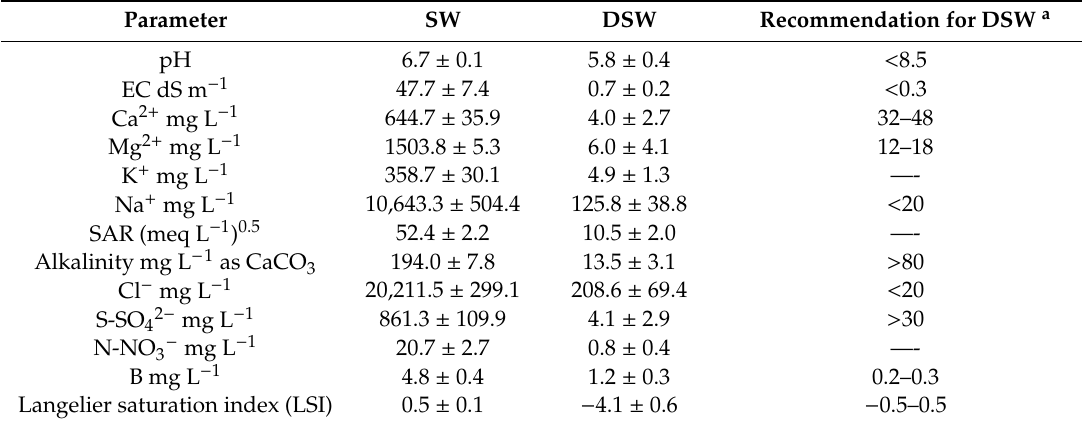
Table 3. General characterization of the seawater catchment (SW) and desalinated seawater (DSW) used for irrigation in the Southeast of Gran Canaria during 2003–2019 period; average +/ − standard deviation; n = 30.